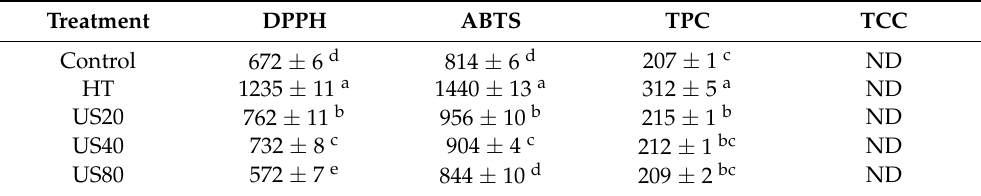
Table 3. Antioxidant activity by DPPH · and ABTS · + methods ( µ M TE), TPC (mg EAG mL − 1 ) and